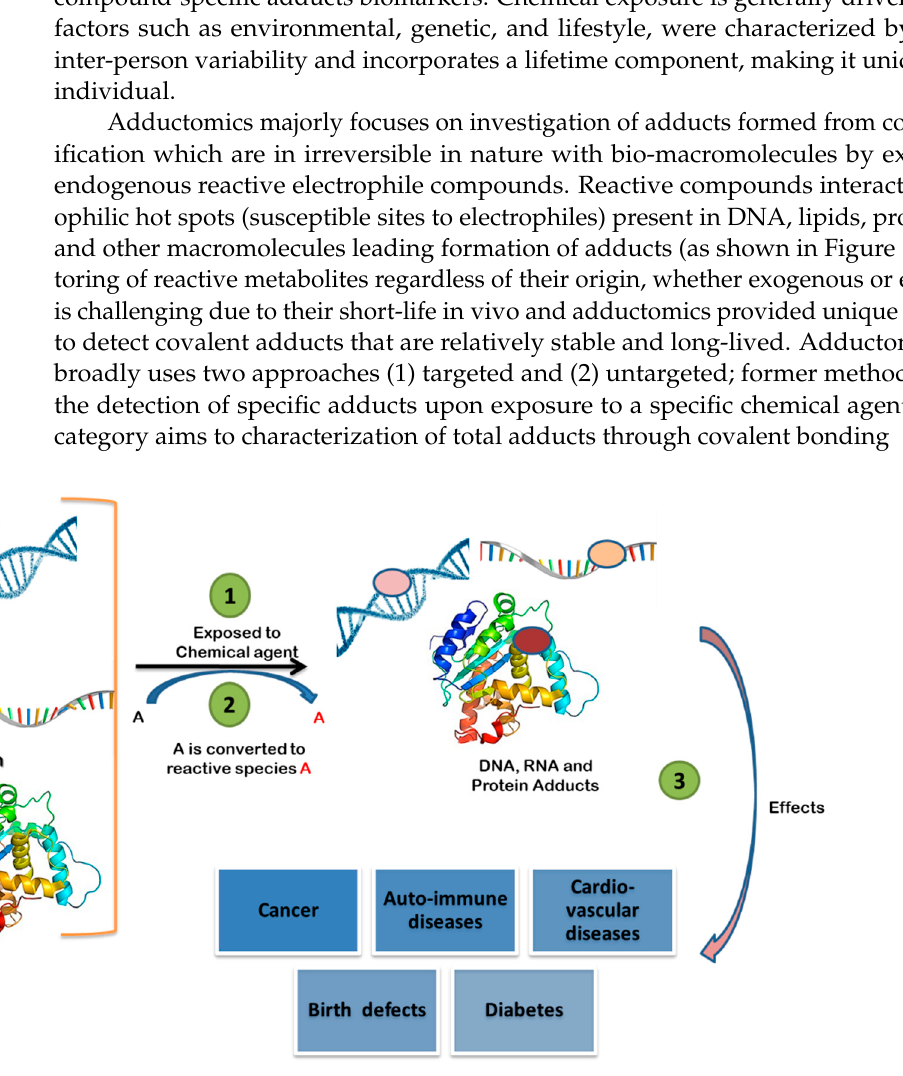
Figure 1. Schematic representation of how chemical agents reacts with DNA, RNA and proteins in cells and leading formation of respective adducts, followed by their resulting in toxicological outcomes. In the figure 1) indicating the exposure to toxicant 2) at cellular level due to enzymatic activity production reactive species or metabolites which are highly reactive than parent molecule 3) generated reactive molecules interact with various cellular components such as protein, RNA and DNA and leading to cause of various pathological outcomes.